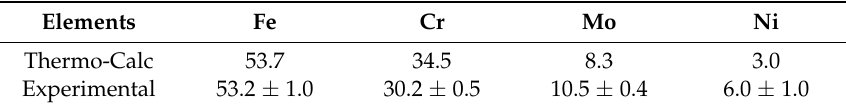
Figure 8. SDSS equilibrium phase diagram calculated thermodynamically with the aid of Thermo-Calc software. Table 2. Chemical composition of the sigma phase (mass (%)) at Thermo-Calc 800 °C and experimental 800 °C for 108,000 s.